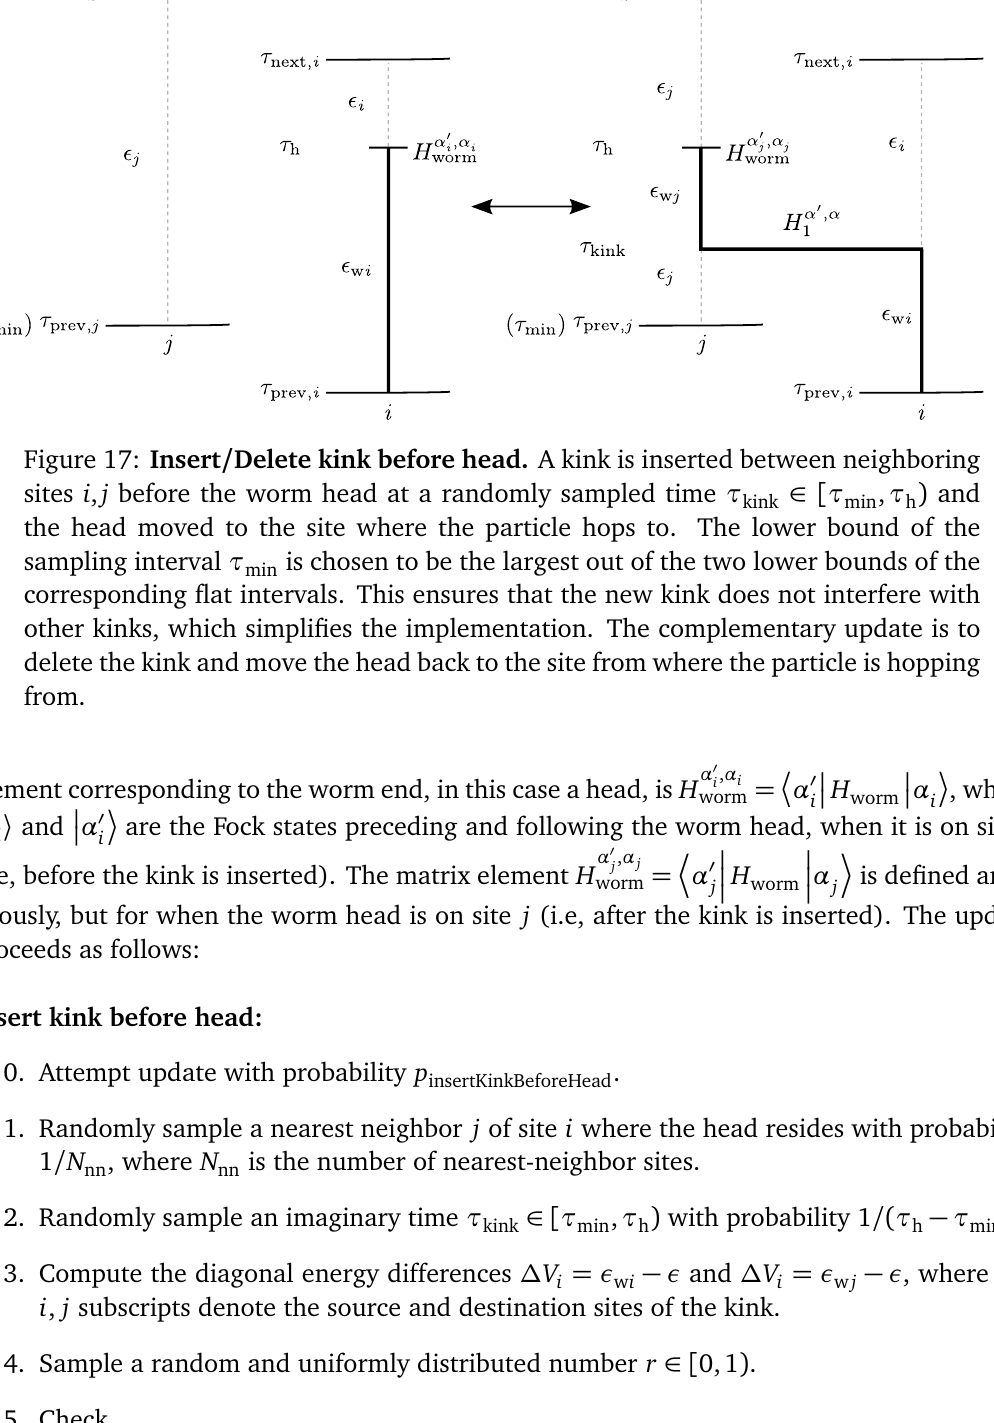
∈ [ τ ) and , τ kink min h